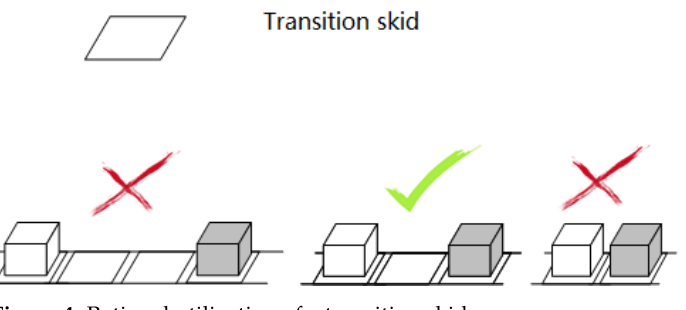
Figure 4. Rational utilization of a transition